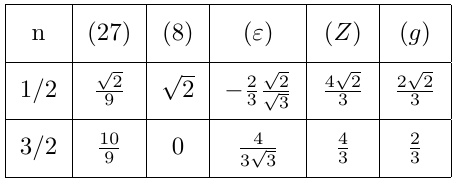
Table 1 . LO contributions a ( X )